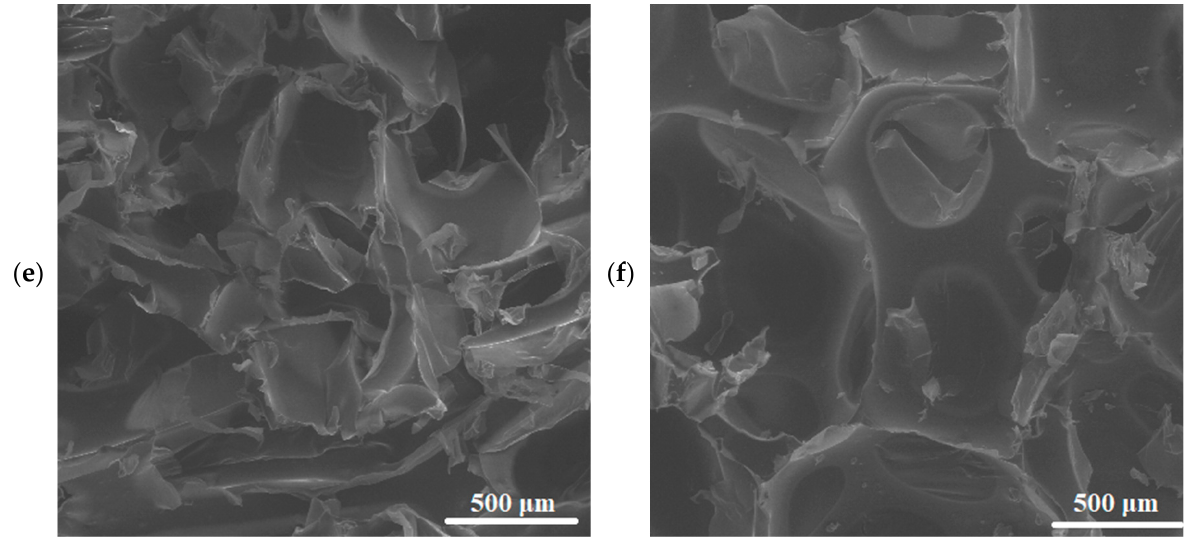
Figure 7. SEM images of the PU_FA ( a ), PU_PFA ( b ), PU_1SFA ( c ), PU_2SFA ( d ), PU_1SPFA ( e ), PU_2SPFA ( f ).